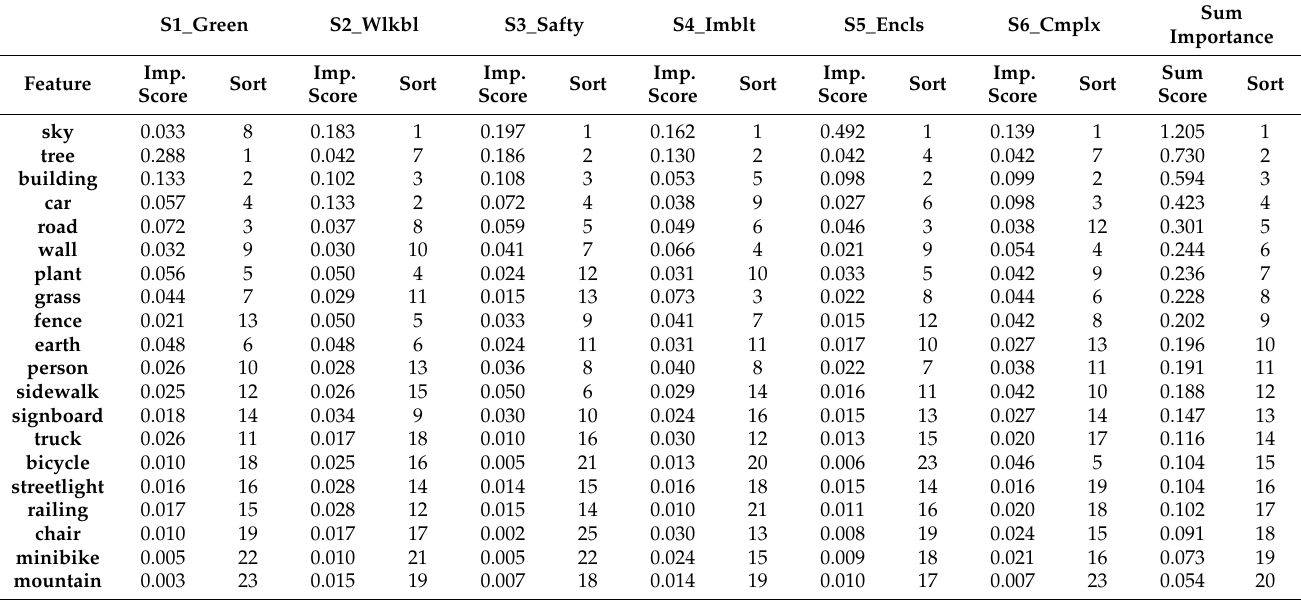
Table 5. Features global importance (GI) in predicting six subjective